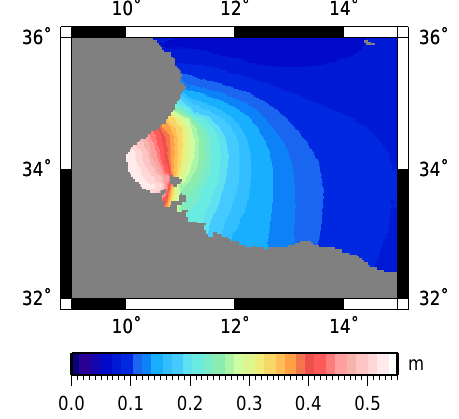
Fig.10. AmplitudeoftheO1constituent